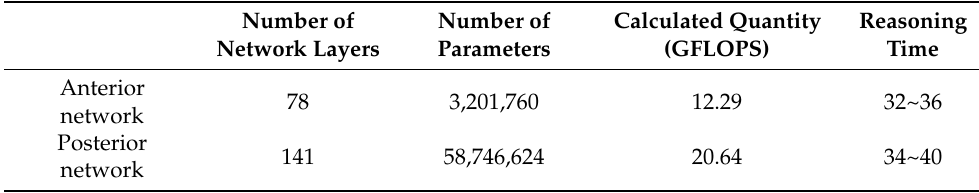
Table 1. Statistics of network